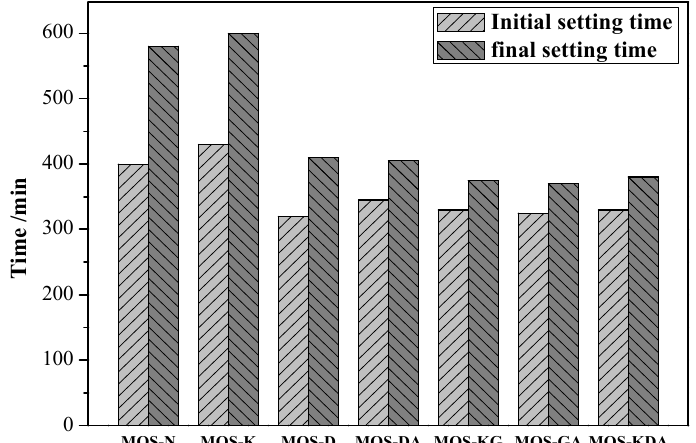
Figure 2. Initial and final setting times for magnesium oxysulfate cement-boron mud blends mixed with different modifiers.